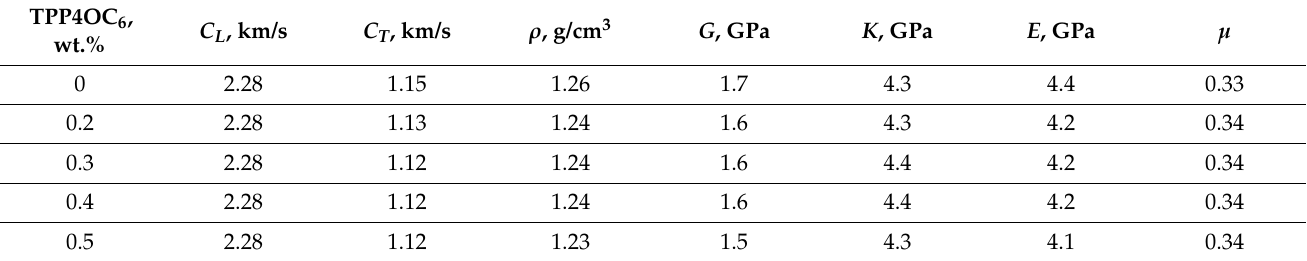
Table 2. Results of ultrasonic measurements of the elastic characteristics of PLA–TPP4OC6